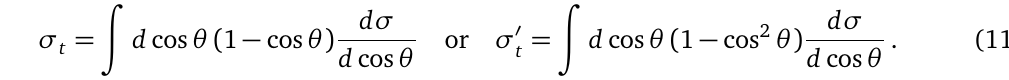
Figure 2: Constraints from DAO on dark atoms with m (left) or 0.3 (right) and f Taken from Ref. [ 25 ]